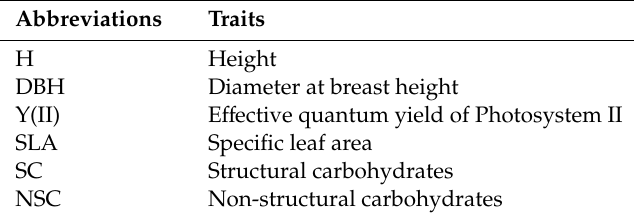
Table 2. Abbreviations and definitions of traits in this